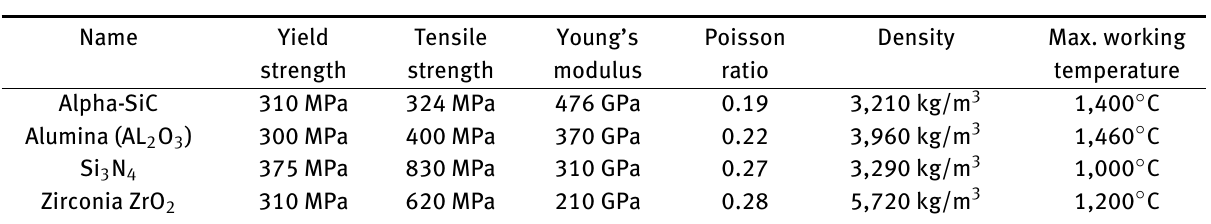
Table 2: Mechanical properties of ceramics at 20 ∘ C [29]